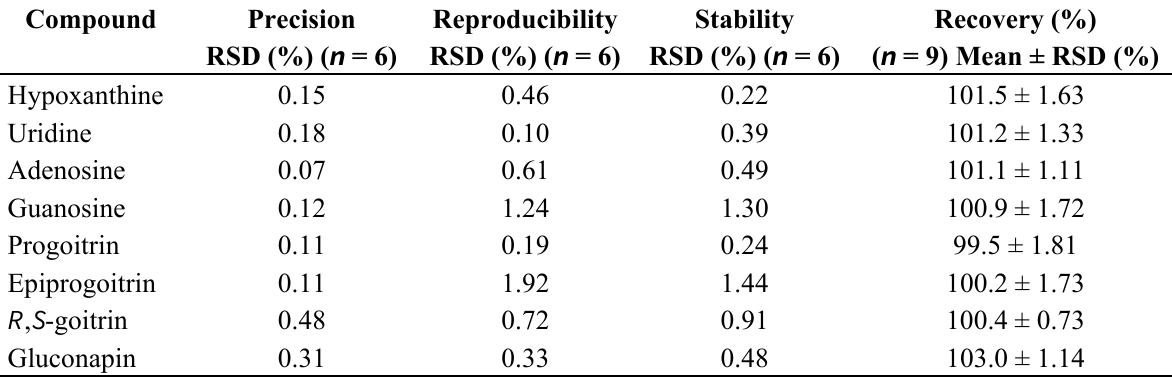
Table 2. Precision, reproducibility, stability, and recovery of the eight bioactive constituents. Compound